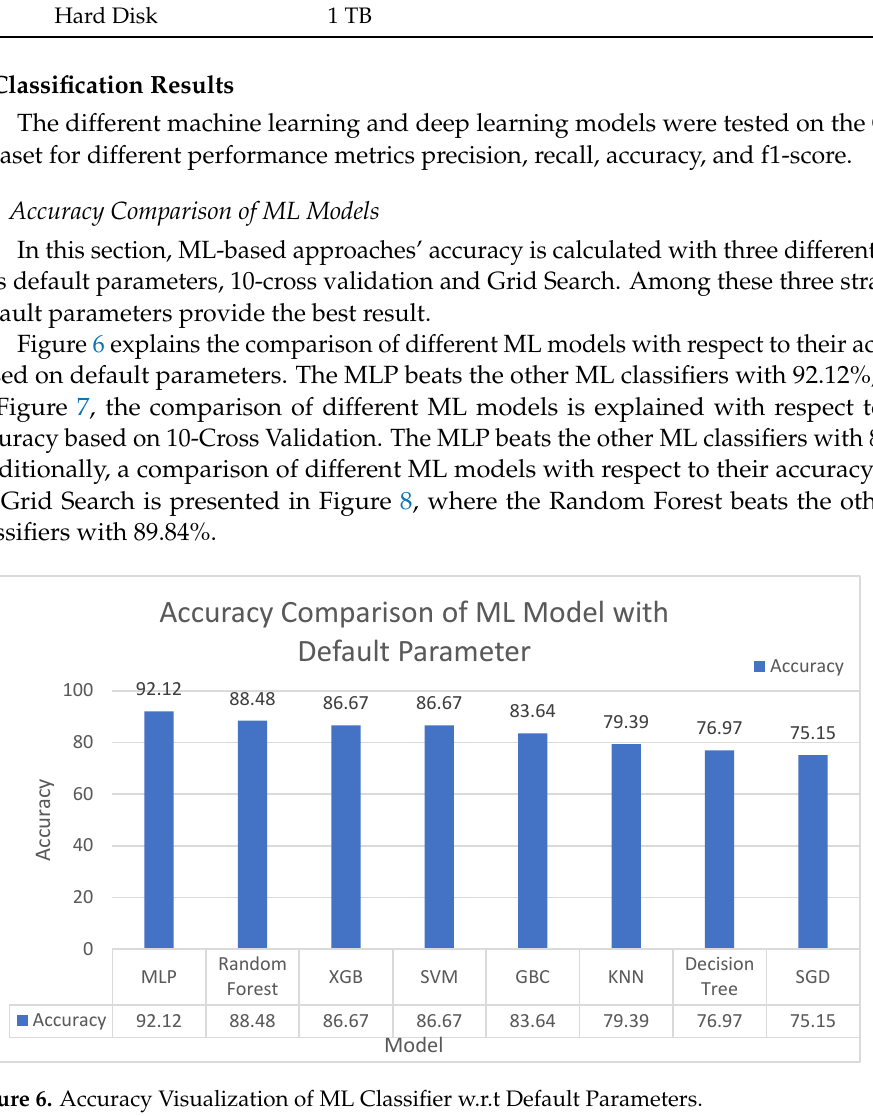
Figure 7. Accuracy Visualization of ML Classifier w.r.t 10-Cross Validation.